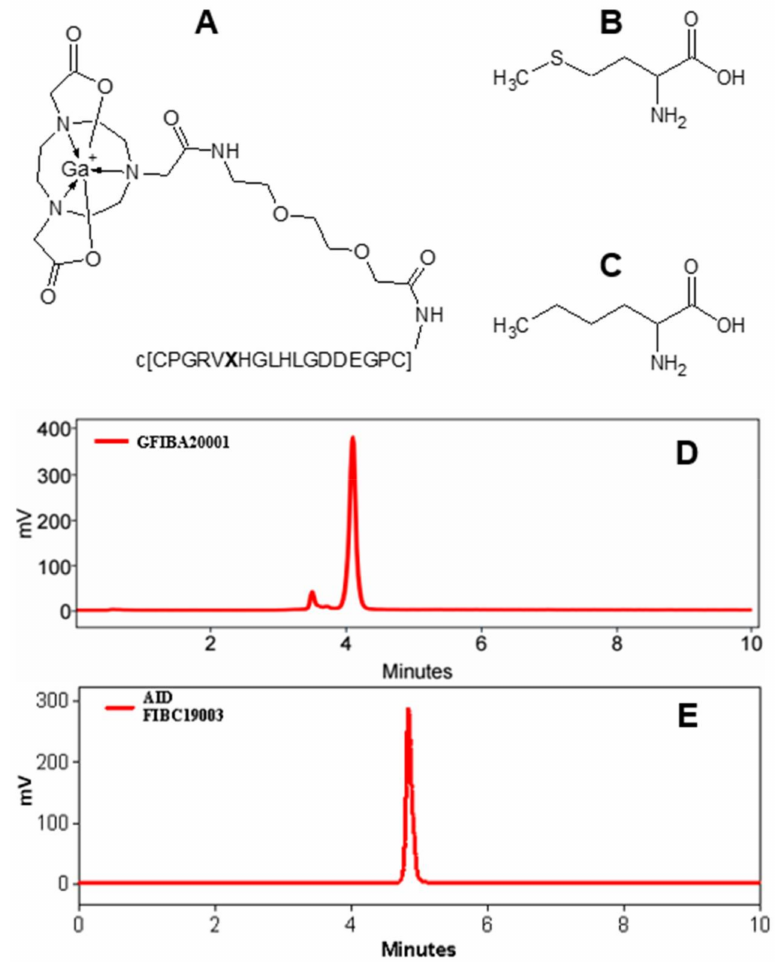
Figure 1. Chemical structures of [ 68 Ga]Ga-NO2A-[ X 13 ]-Col ( A ), where X stands for either methionine ( B ) or norleucine ( C ). c[CPGRV X HGLHLGDDEGPC] is a cyclic peptide coupled to the chelator moiety via an ethylene glycol linker (EG 2 ). ( D ) Radiochromatogram of [ 68 Ga]Ga-NO2A-Col showing the by-products of radiolysis with a retention time below 4 min. ( E ) A typical radiochromatogram of [ 68 Ga]Ga-NO2A-[Nle 13 ]-Col demonstrating the absence of the